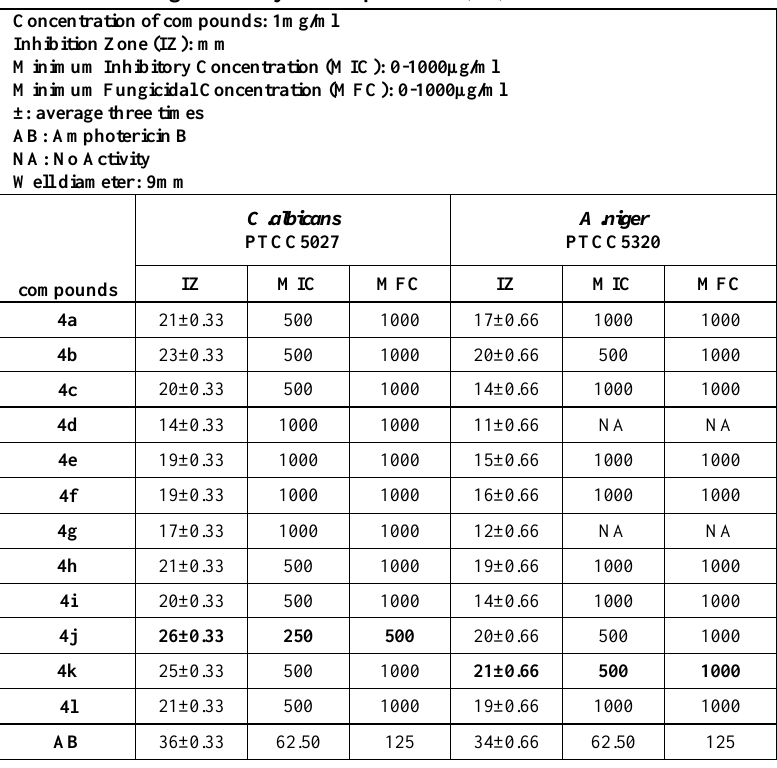
Table 4. Antifungal activity of compounds 4(a-l). 352 Concentration of compounds: 1mg/ml Inhibition Zone (IZ):